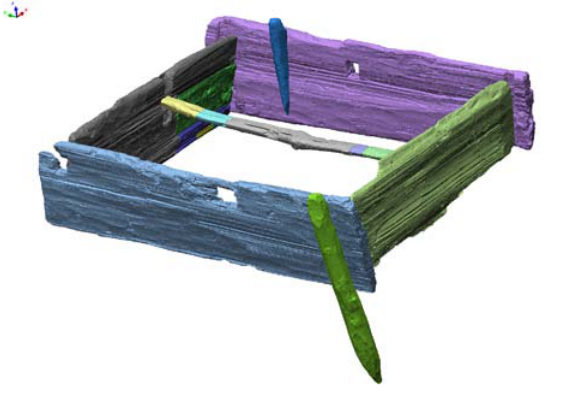
Figure 1. The high-resolution documentation and virtual reconstruction of the sluice box